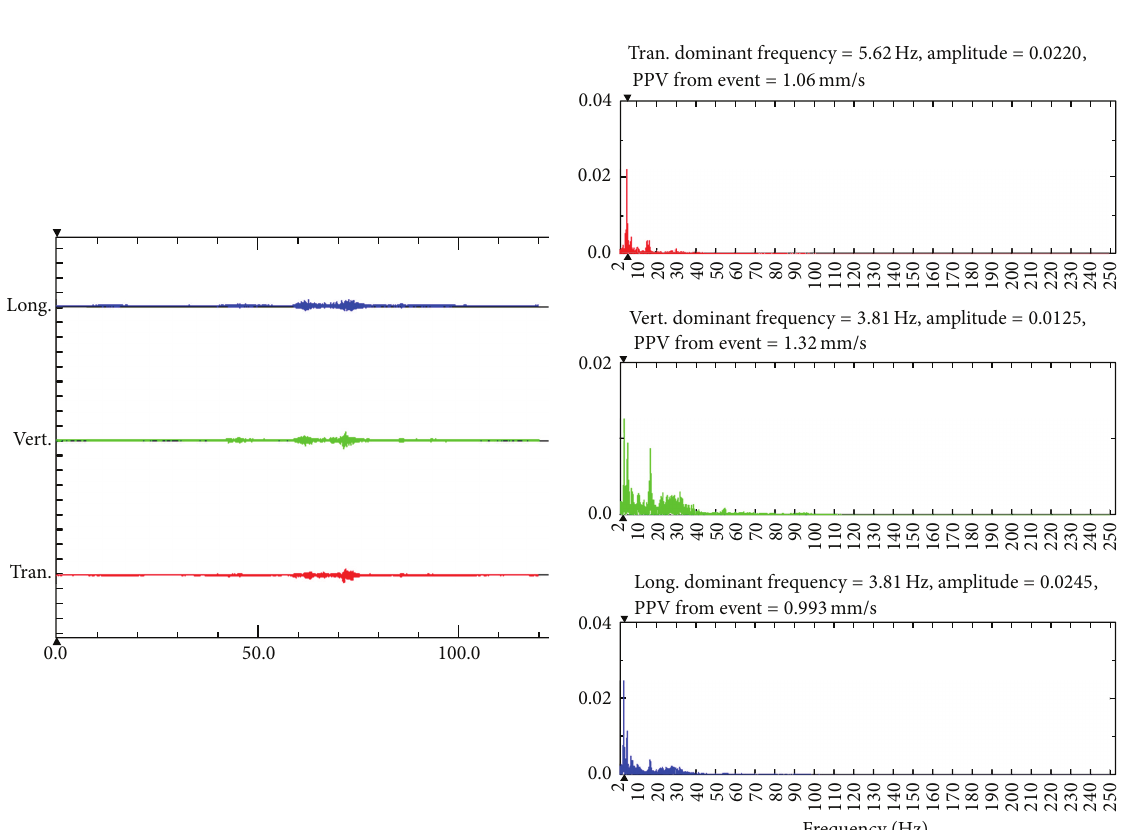
Figure 8: Measurement on moveable station 7R (over the